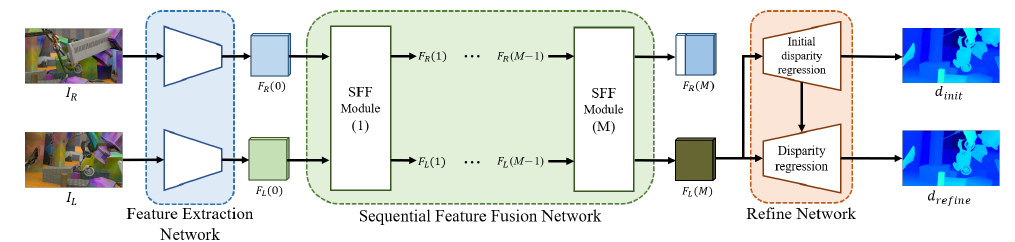
Figure 1. An overview of the proposed